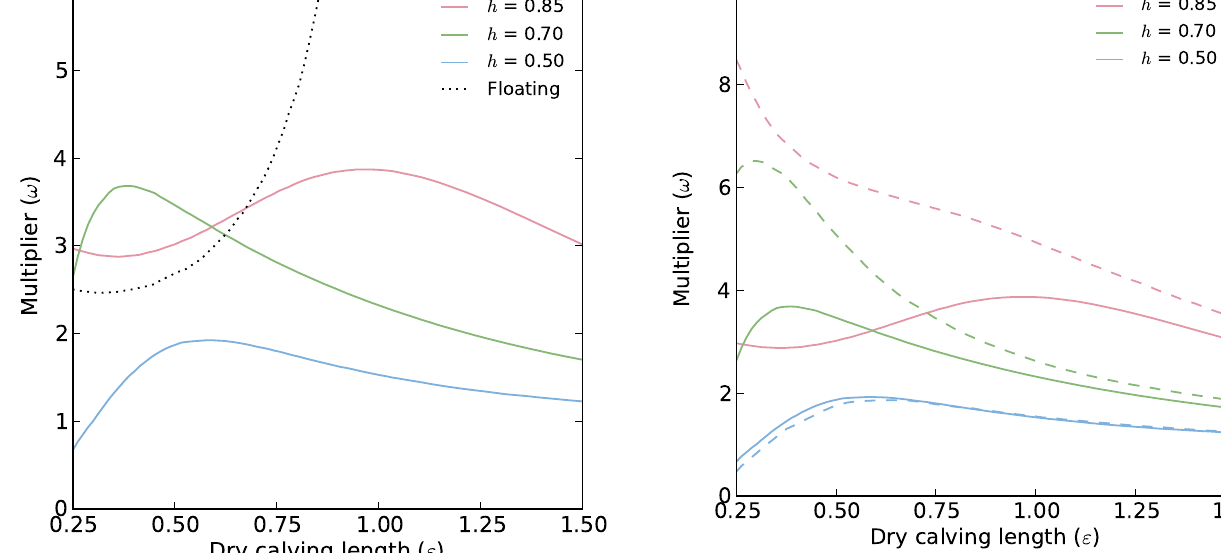
Fig. 4. Relationship of wet calving multiplier ω to calving length ε for varying water depths. Also shown is the floating case, where ω rapidly diverges.